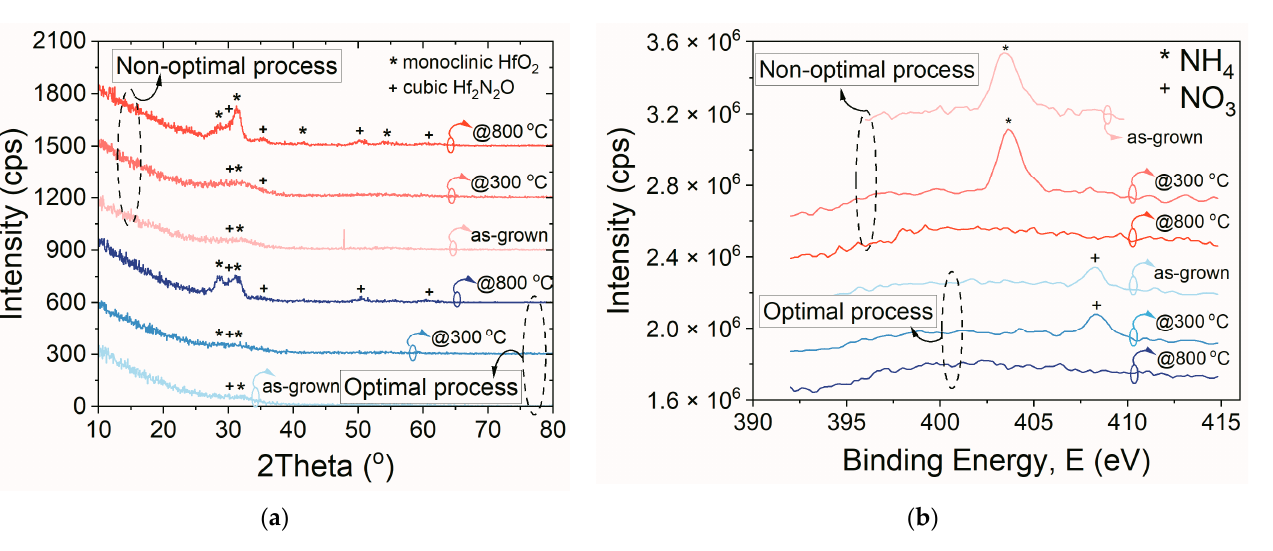
Figure 7. GIXRD patterns ( a ) and N1s photoelectron spectra ( b ) of HfO x N y thin films (as-grown and annealed at 300 °C or 800 °C).